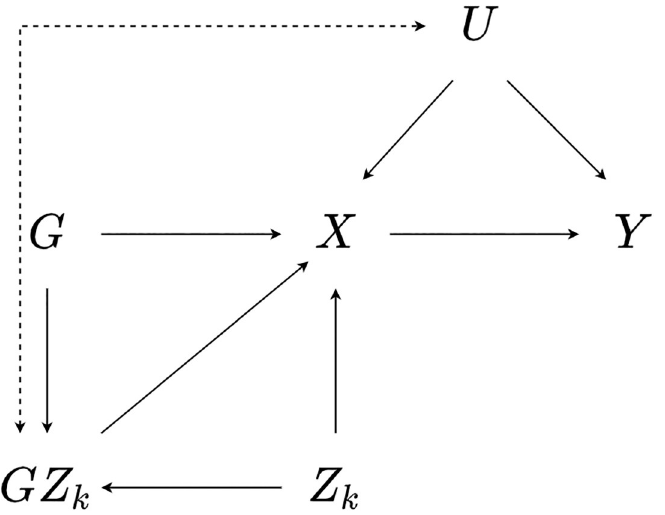
Fig 3. Illustration of general GxE2 violation. A directed acyclic graph showing the relationship between a genetic instrument G , interaction covariate Z k , exposure X , outcome Y , and one or more confounders U . In this case, the presence of an association between a gene-by-covariate GZ k and U violates assumption